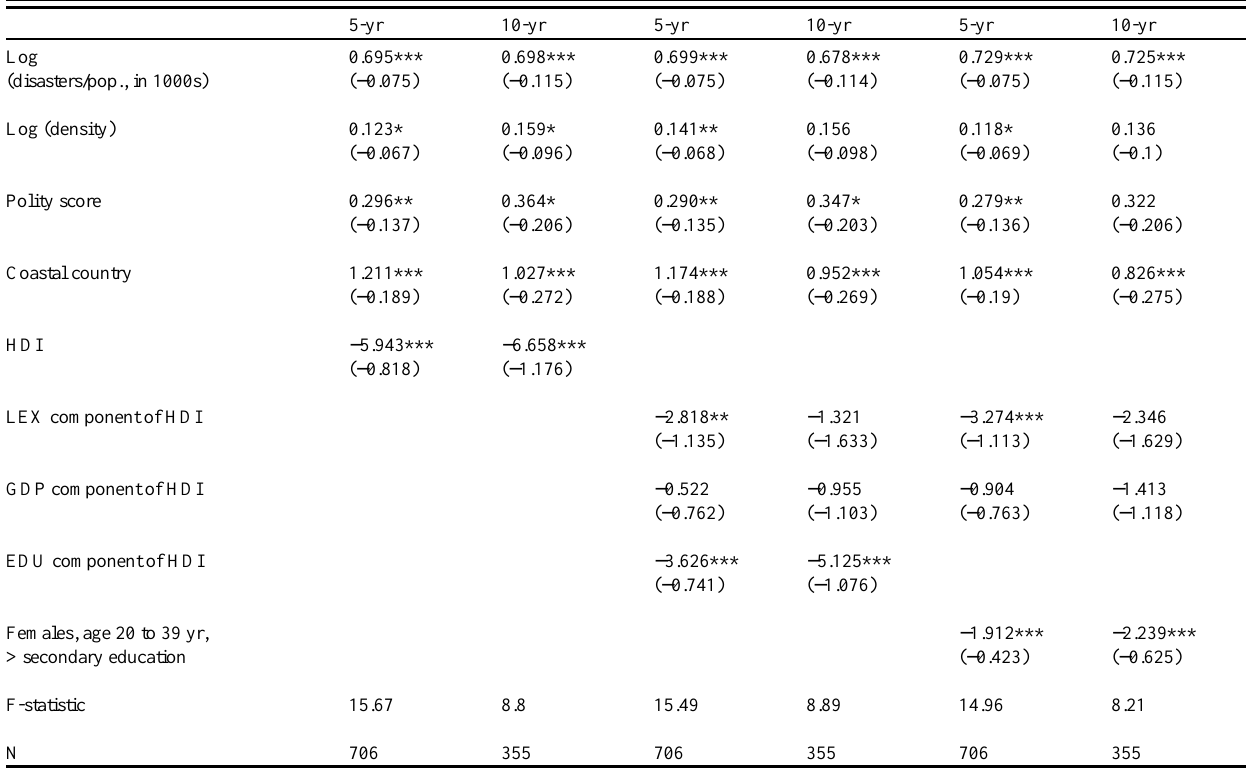
Table 1 . Determinants of national death from natural disaster. Panel regression for 125 countries over 5-year and 10-year intervals between 1980 and 2010 using time fixed effects. The dependent variable is the log of deaths per capita. Numbers in parentheses are standard errors based on the heteroskedasticity-reistant and autocorrelation-resistant covariance matrix. HDI = human development index. LEX = life expectancy at birth. EDU = education. Other independent variables not reported here are dummy variables for 17 world regions. Significance codes: 0.01 = ***; 0.05 = **; 0.1 = *.